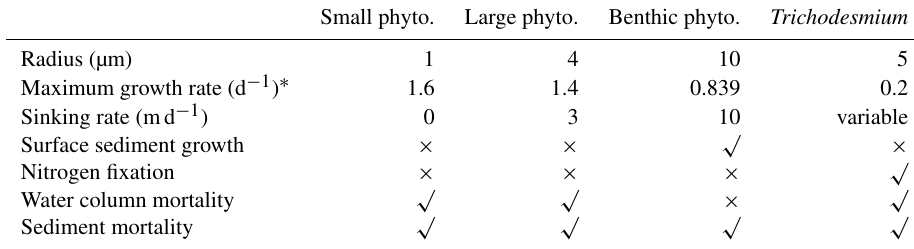
Table 3. Traits of suspended microalgae.